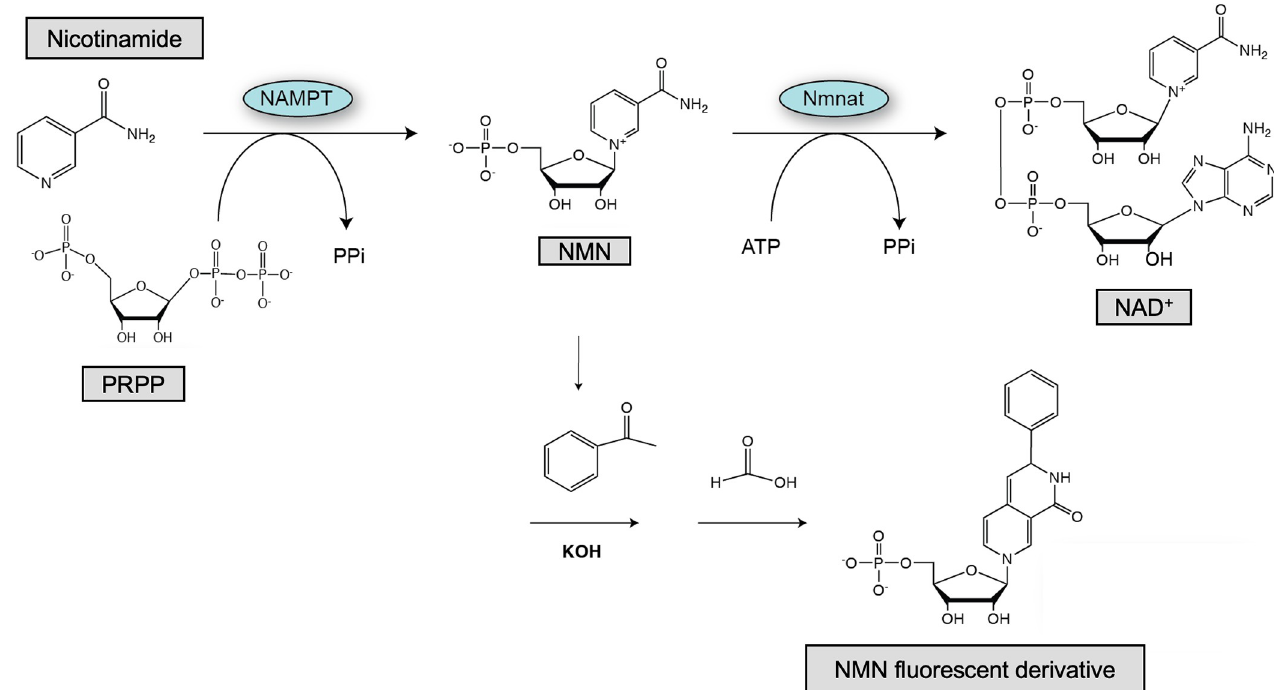
Fig 1. Schematic of NAD+ biosynthetic pathway and NAMPT enzymatic assay.